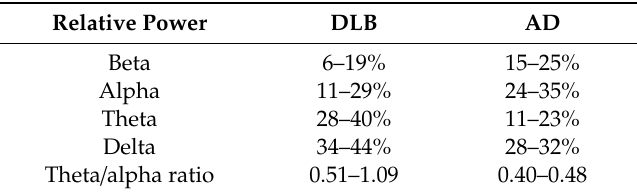
Table 2. Comparison of relative band power between dementia with Lewy bodies and Alzheimer’s disease. Relative